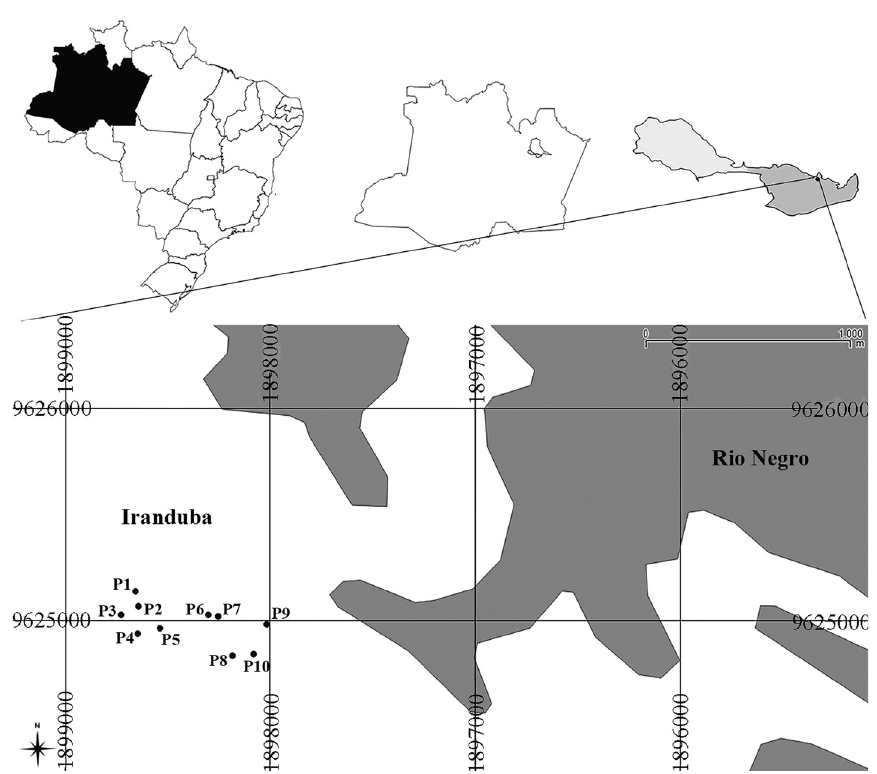
Figure 1. Clay pits (P1 to P10) used